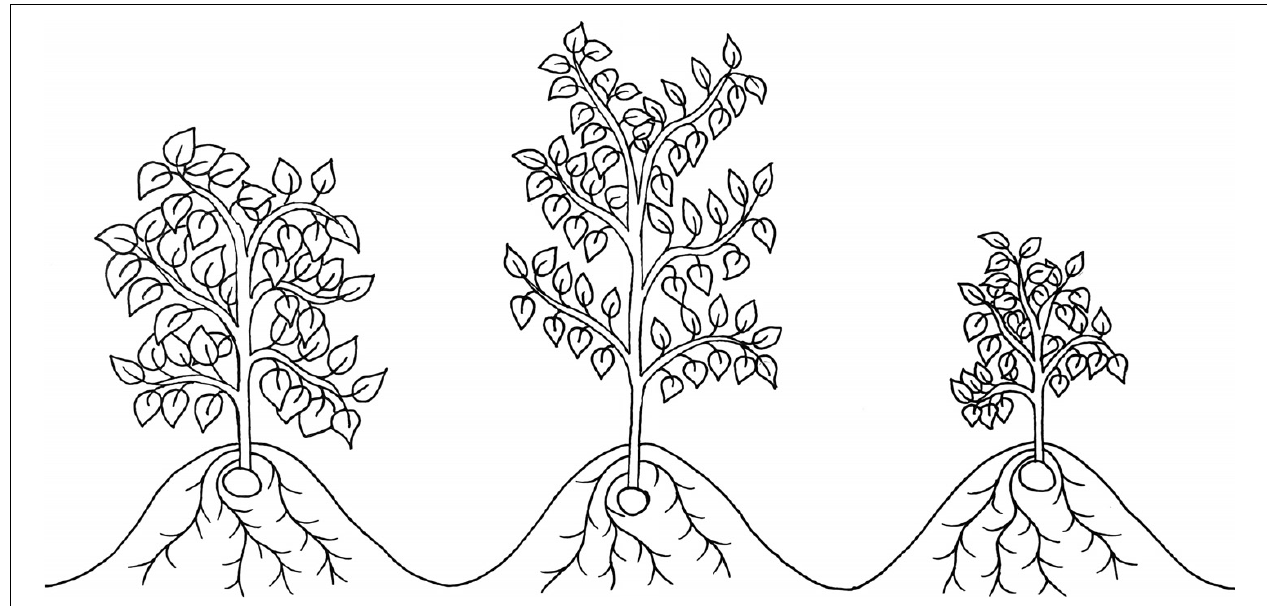
FIGURE 2 | An illustration of three canopy architectures, two of which have been suggested to improve drought tolerance in potato: open “stem-type” canopies, e.g., cv. Tomba, which may improve light penetrance and interception (middle), and very small canopies, e.g., cv. Alpha, which may reduce evapotranspirative water loss (right). A dense “leaf-type” canopy, e.g., cv. Procudent, which has been suggested to be detrimental to potato yields under drought is also illustrated (left).